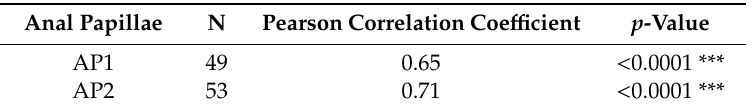
Table 1. Correlation between two independent measurements (calculated from absolute values of di ff erences between right and left anal papillae of D. melanogaster larvae), *** p < 0.001.